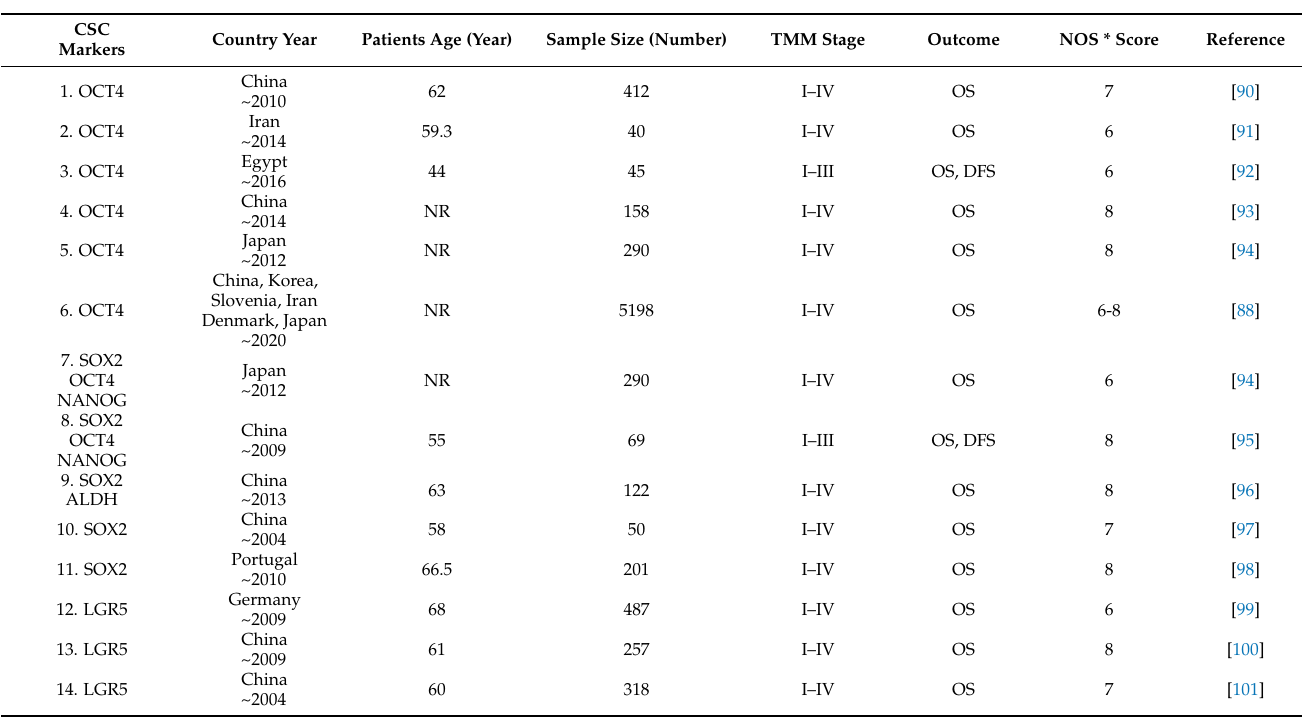
Table 3. Meta-analysis of gastric CSC markers